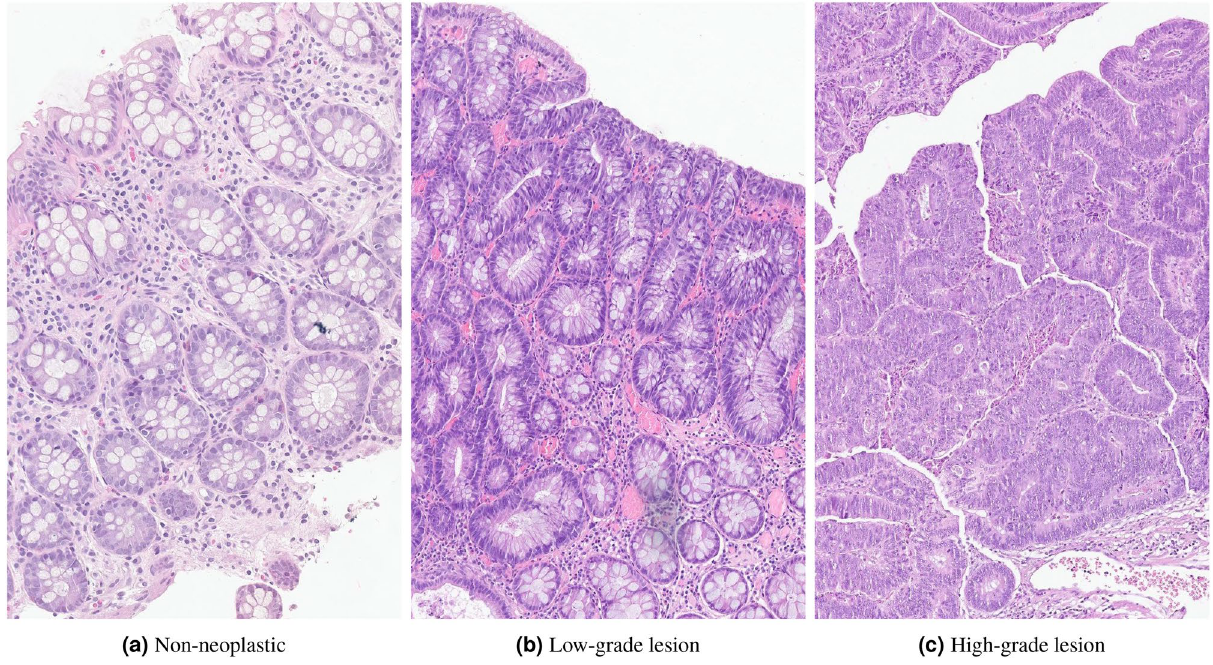
Figure 2. Normal colonic mucosa and dysplastic